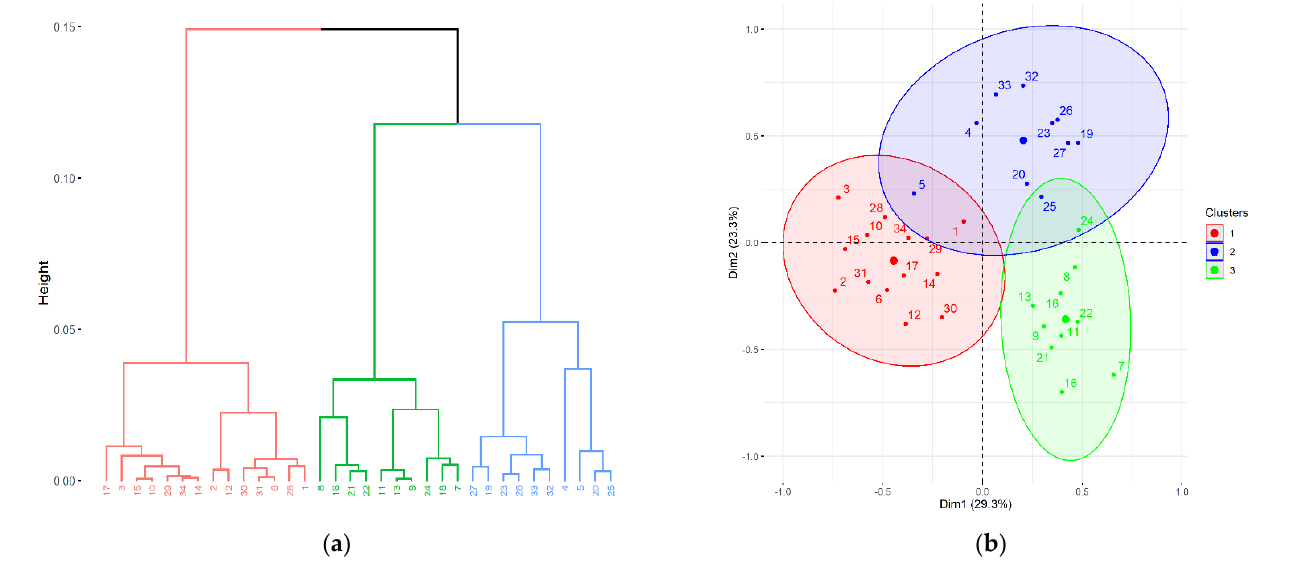
Figure 3. Distribution and grouping of the 34 farms surveyed; ( a ) cluster dendrogram; ( b ) result of the hierarchical clustering (HCPC). Ellipses are centered on the barycenter of the groups (non-labeled large points). The first two dimensions of the MCA explain 52.6% of the variance (Dimension 1, 29.3%; Dimension 2, 23.3%).